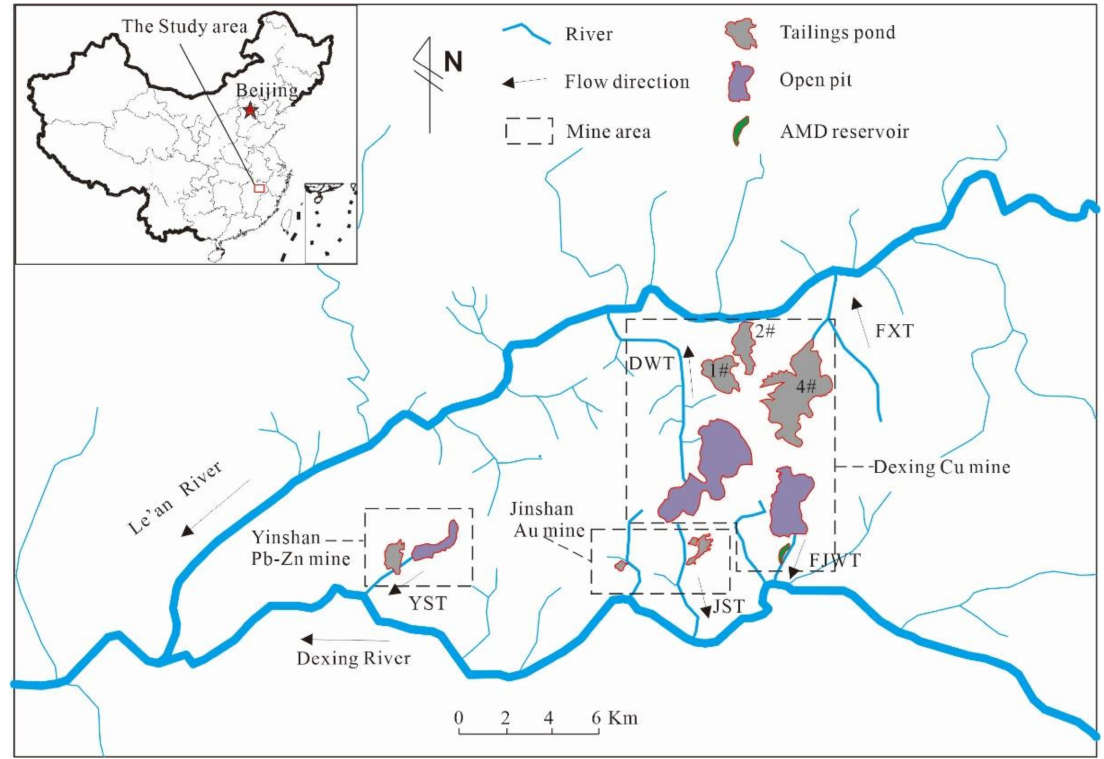
Figure 1. Location of the study area. FXT-Fuxi tributary, DWT-Dawu tributary, FJWT-Fujiawu tributary, JST-Jinshan tributary, YST-Yinshan